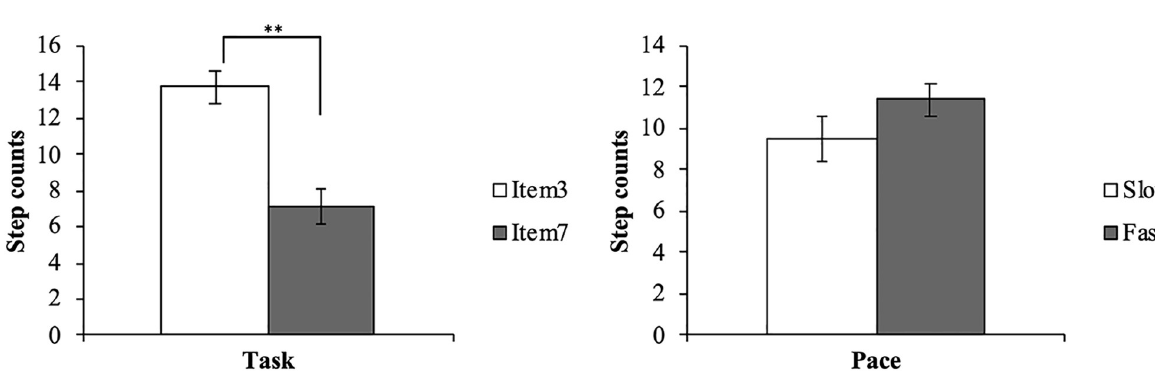
Fig 5. Two-way repeated-measures ANOVA for time. Time represents the time taken for each trial, �� p < 0 . 01 , � p < 0 . 05 .